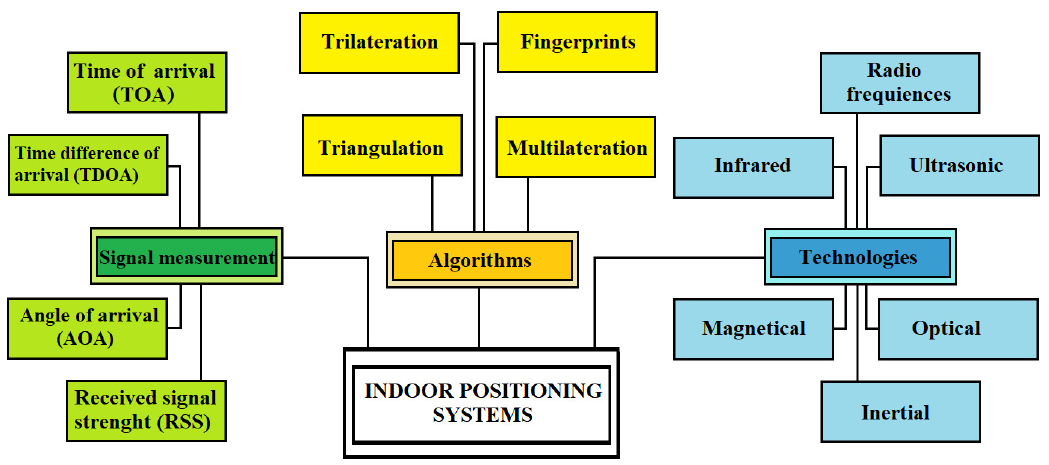
Figure 1. Indoor positioning systems.